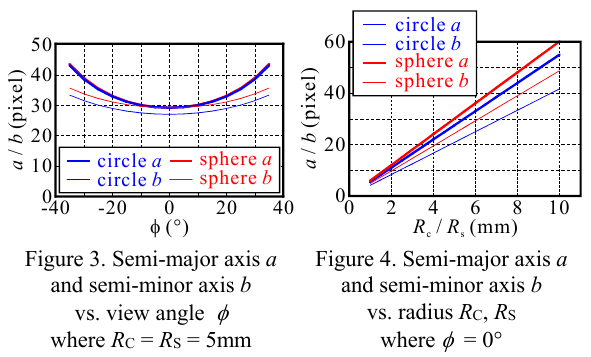
Figure 3. Semi-major axis a and semi-minor axis b